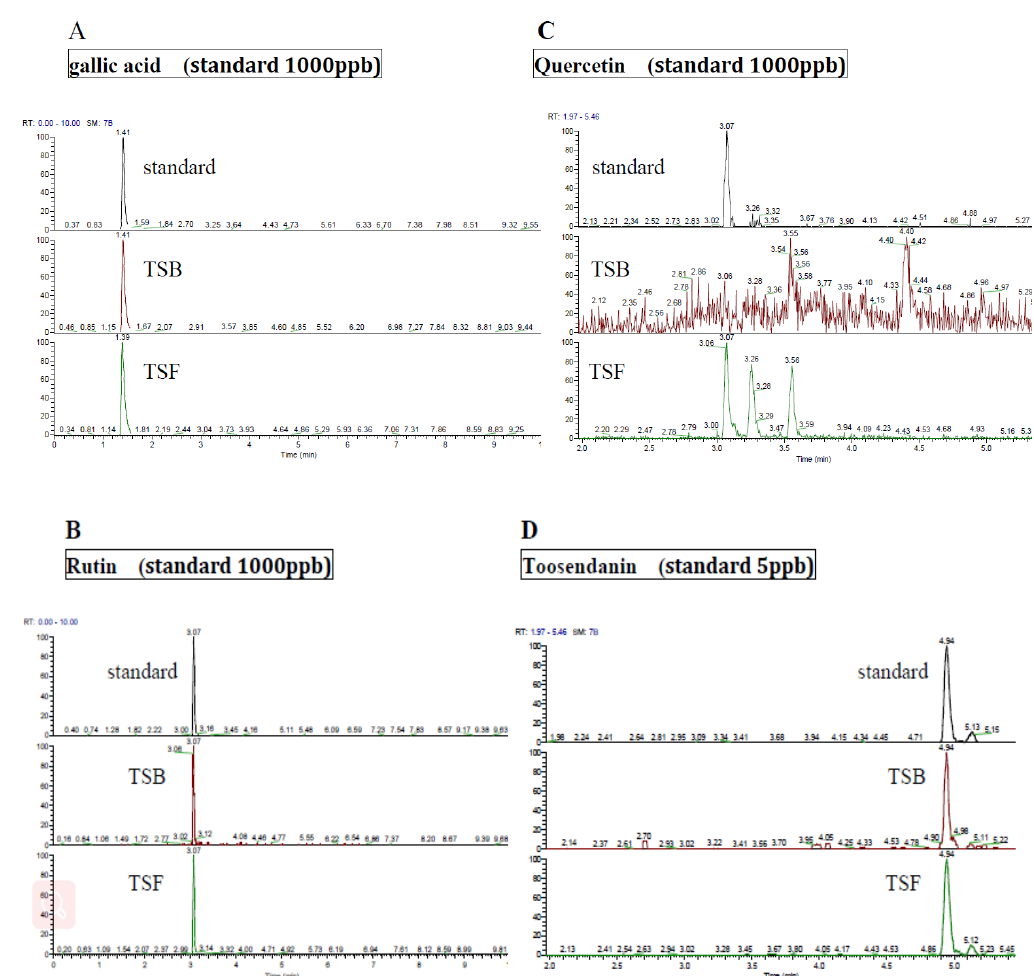
Figure 1. LC – MS analysis of T. sinensis leaves, root, or bark (TSB) and T. sinensis fruit (TSF) extracts. ( A ) Gallic acid, ( B ) rutin, ( C ) quercetin, and ( D ) toosendanin. 3.2. FFA Induces Lipid Accumulation in HepG2 Cells The human hepatoma cell line HepG2 was used to mimic FFA-induced steatosis in the human body [9]. Oleic and palmitic acids are the most abundant FFAs in patients with steatosis [28]. A lipid- laden HepG2 cell model was established by adding different FFA levels (oleic acid 0.66 mM, palmitic acid 0.33 mM) for 24 h. As shown in Figure 1, FFA induced lipid accumulation in a concentration- dependent manner (Figure 2A,B) without cytotoxicity (Figure 2C). FFA (1 mM) induced about twofold lipid accumulation in HepG2 cells based on Oil Red O staining.